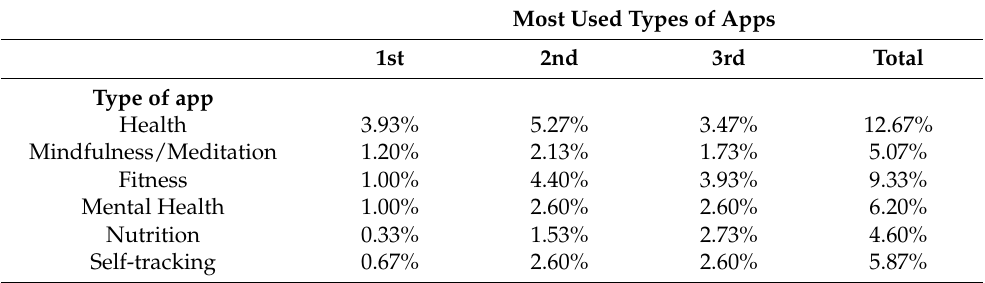
Table 5. Ranking of the three most used types of apps (%).